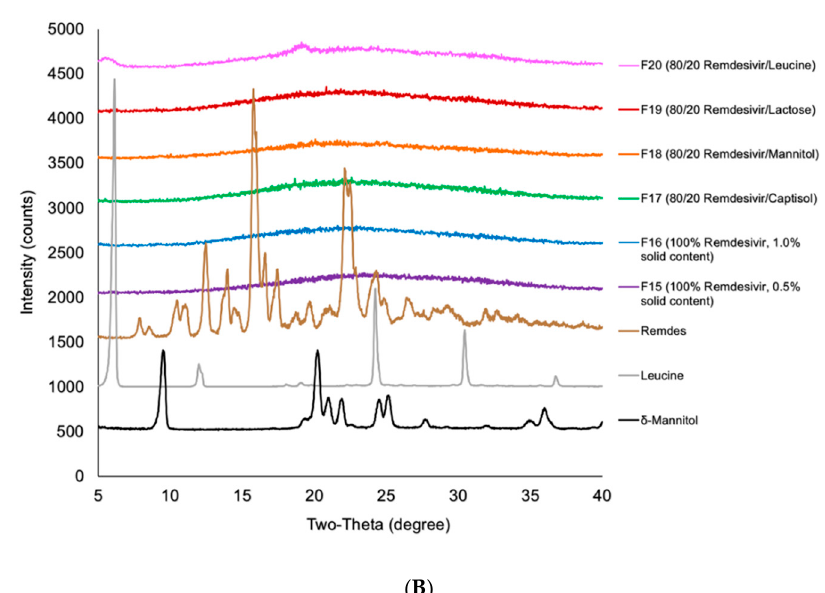
Figure 2. X-ray powder diffraction (XRPD) diffractograms of TFF remdesivir compositions; ( A ) formulations prepared in acetonitrile / water (50 / 50) solvent mixture; ( B ) formulations prepared in 1,4-dioxane / water (50 / 50) solvent mixture.